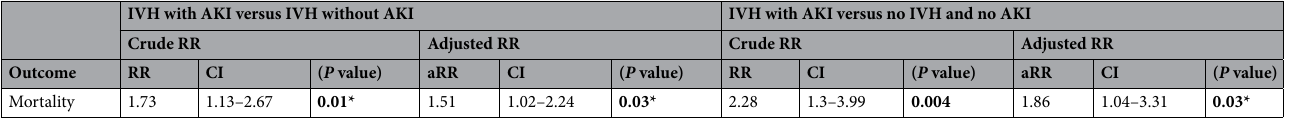
Table 5. Multivariable analysis of neonatal mortality stratified by IVH with AKI versus IVH without AKI and by IVH with AKI versus no IVH or AKI. Abbreviations: IVH intraventricular hemorrhage, AKI acute kidney injury, RR relative risk, CI confidence interval. *Statistically significant at 5% level. Bold values indicate all values less than 0.05 are significant.